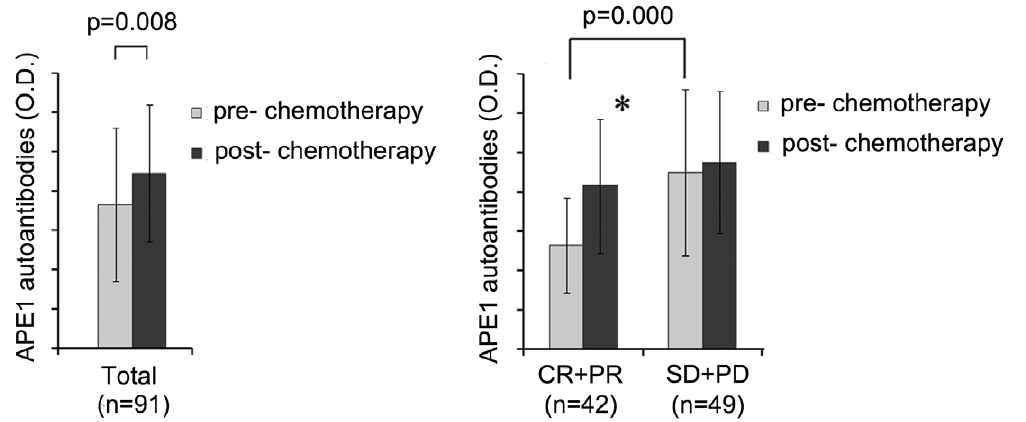
Figure 5. Distribution of serum APE1-AAbs before and after chemotherapy. The serum APE1-AAbs level was much higher in the poor chemotherapeutic response group than in the good response group ( p =0.000). There was a significant difference in the group with good platinum- based chemotherapeutic response before and after chemotherapy ( p , 0.001), while there was no difference in the group with poor platinum-based chemotherapeutic response before and after chemotherapy ( p =0.393). *before chemotherapy versus after chemotherapy ( p , 0.001). p value were obtained after comparing the levels APE1-AAbs of pre- and post- chemotherapy, as determined by paired t -test.